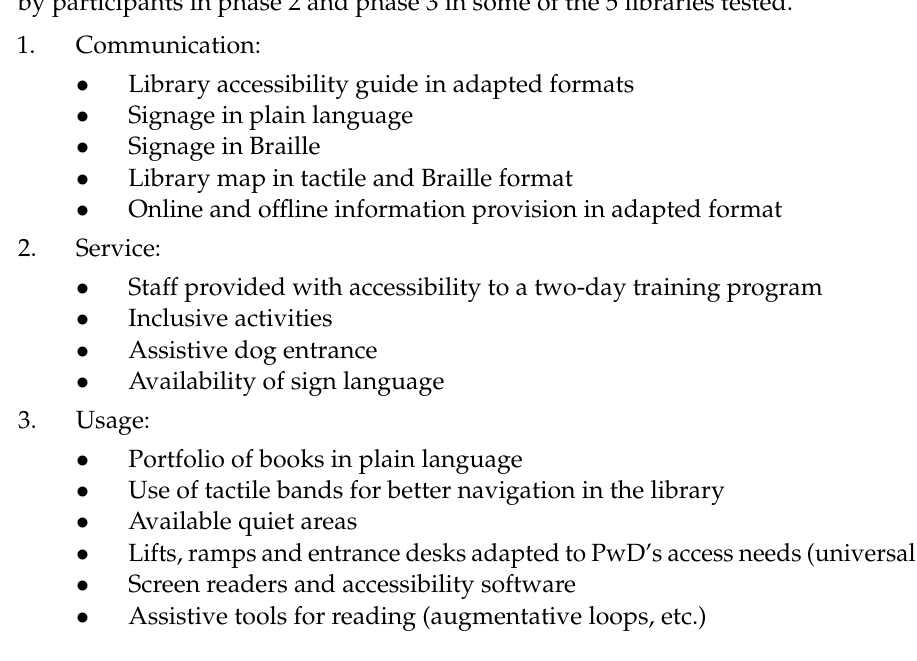
encounters. ( A ) Library guide needs to be adapted to the communication needs of users (plain language, Braille, etc.). ( B )